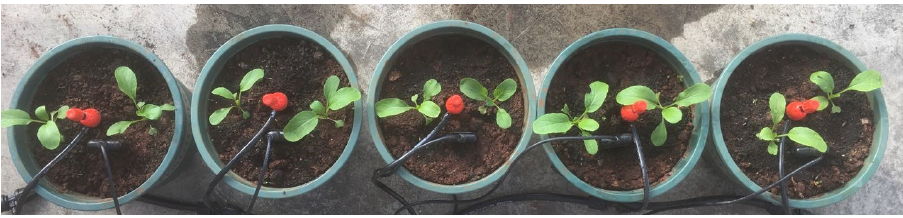
Figure 1. Study area: ( a ) the geographic location of Guangzhou within China; ( b ) the location of the study area in Guangzhou; ( c ) a top view of the study area taken from Google Maps.